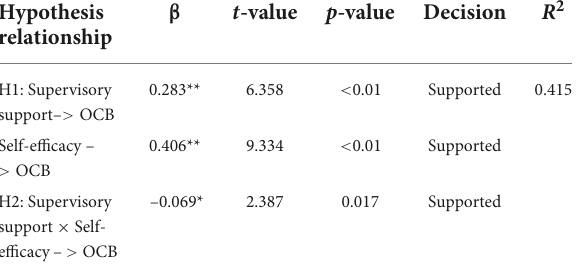
TABLE 5 The structural model results.